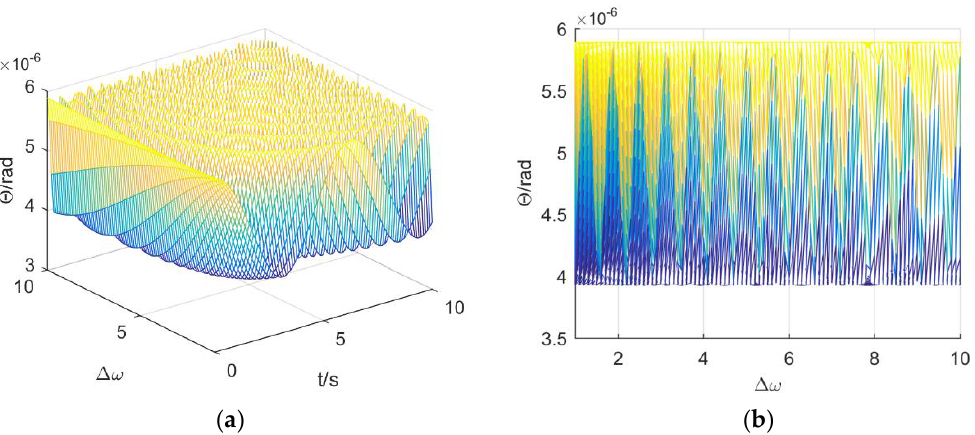
Figure 10. Given α = 5, ∆ φ = π , the influence of frequency difference on the peak value of output light angle response: ( a ) The amplitude variation of output light angle response under frequency difference, and time variable; ( b ) the amplitude variation of angular response of frequency difference output light.